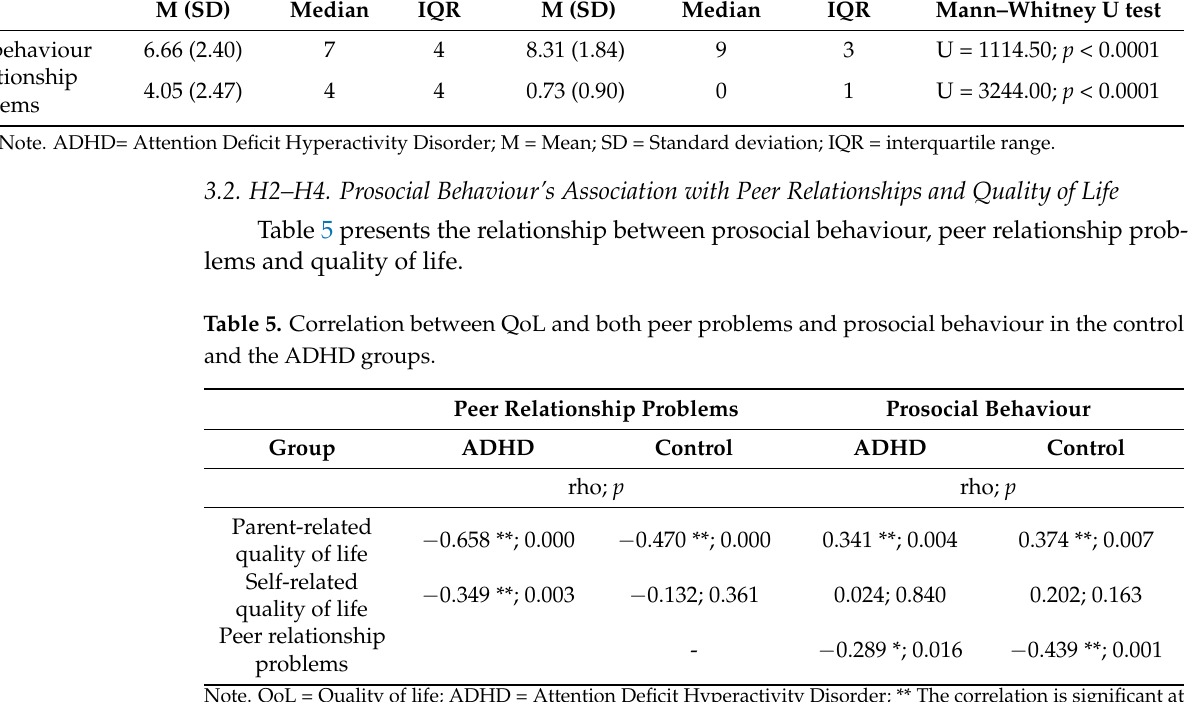
Table 4. Difference between ADHD and control group in prosocial behaviour and peer relationship problems. ADHD Group ( n = 79)